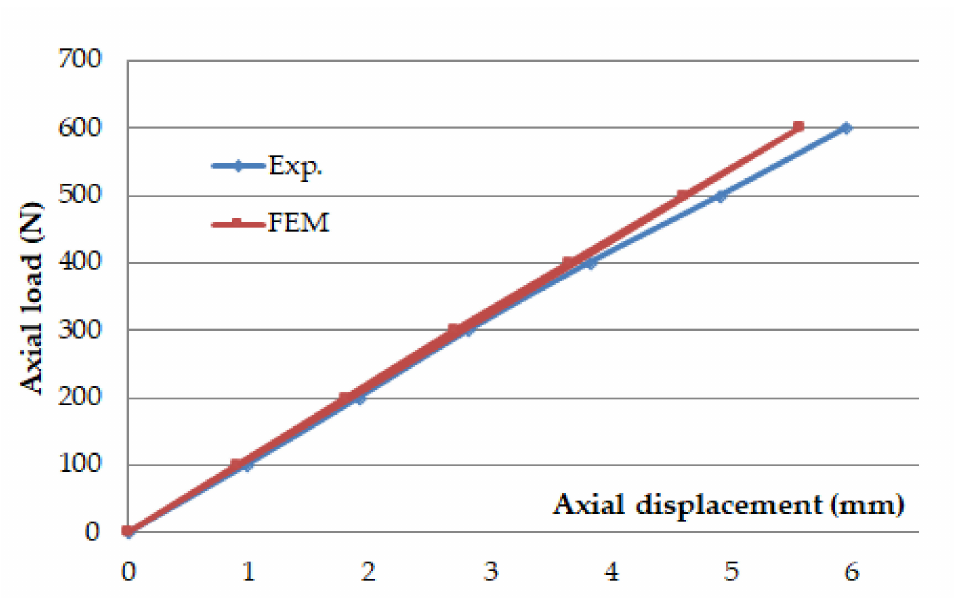
Figure 9. Comparative diagram of the axial displacement at the point of load for configuration B50.